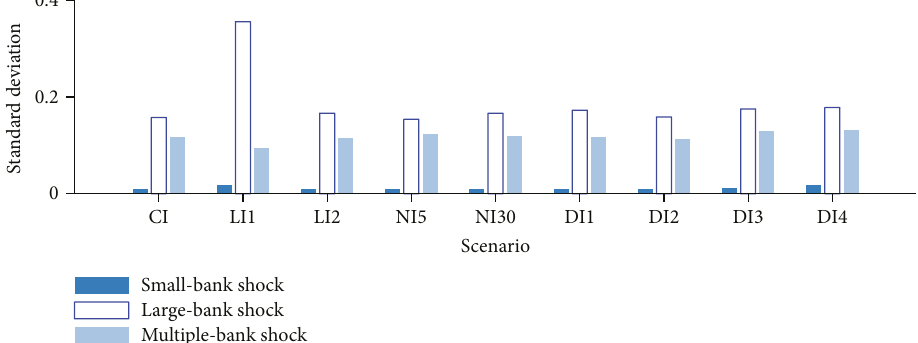
Figure 16: Standard deviations of con fi dence across all scenarios and three shock treatments: to a small bank, a large bank, and multiple banks. CI =Complete information; LI =local information; NI =noisy information; DI=delayed information; LI1 and LI2 =scenarios in which a bank has access only to information at distance 1 and 2, respectively. NI5 and NI30=scenarios in which noise parameter v is 5% and 30%, respectively. The delay scenarios are de fi ned in Table